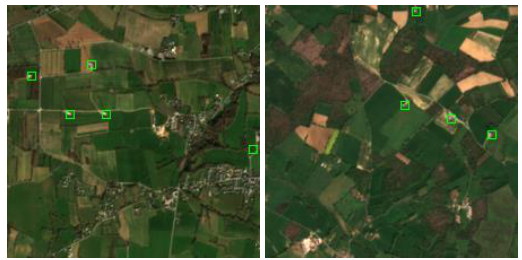
Figure 10 . Good results of detection.